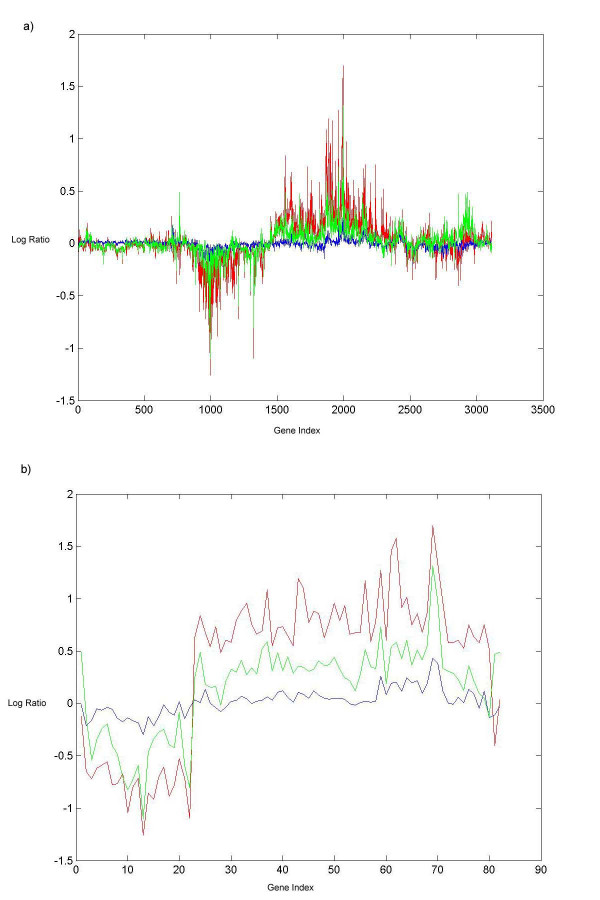
Gene expression components of the phenotypic prototypes. Plotting of the gene expression component of the prototypes from the clusters generated from clustering the acetaminophen data using the modk-prototypes algorithm (with the levels of the necrosis of the centrilobular region of the rat liver included, 100 iterations and the average of the suggested weights of the domain data). a) All genes detected as significantly differentially expressed b) 82 genes significant and unique in distinguishing contrasts between the levels of necrosis of the centrilobular region of the rat liver. The red, blue and green lines denote the gene expression prototype from Clusters 1, 2 and 3 respectively. The log10 ratio values of the genes from the prototypes are signified on the y axis and the indices for the genes are denoted on the x axis.